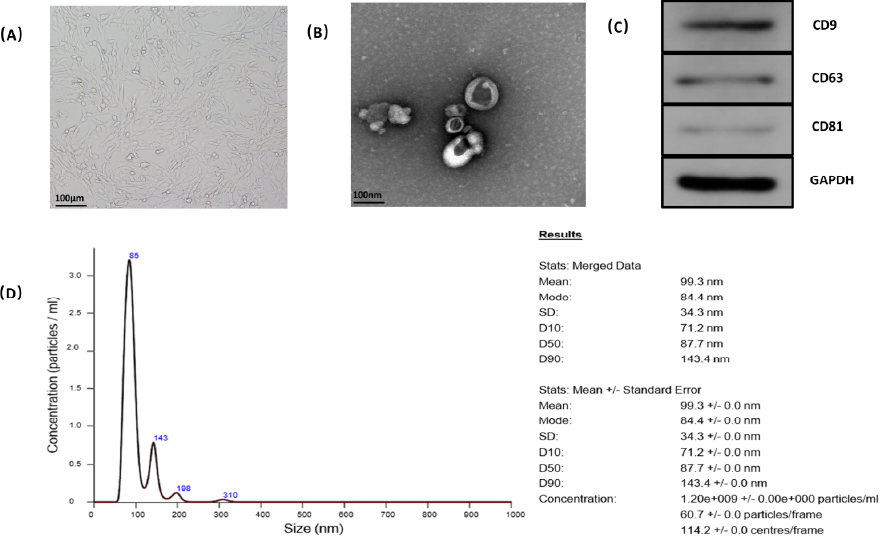
Figure 2. Characterization of BMSC-EVs. ( A ) The fibroblast-like morphology of BMSCs shown by microscope. ( B ) The morphology of BMSC-EVs shown by scanning electron microscopy. ( C ) Expression of CD9, CD63, and CD81 incorporation into BMSC-EVs shown by Western blotting. ( D ) Identification of size and concentration of BMSC by nanoparticle tracking analysis.